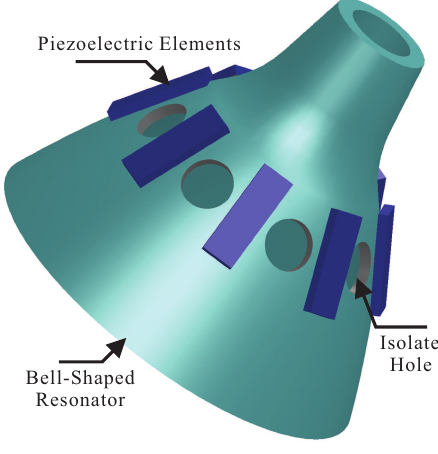
Figure 1. The schematic of the bell-shaped resonator’s structure.